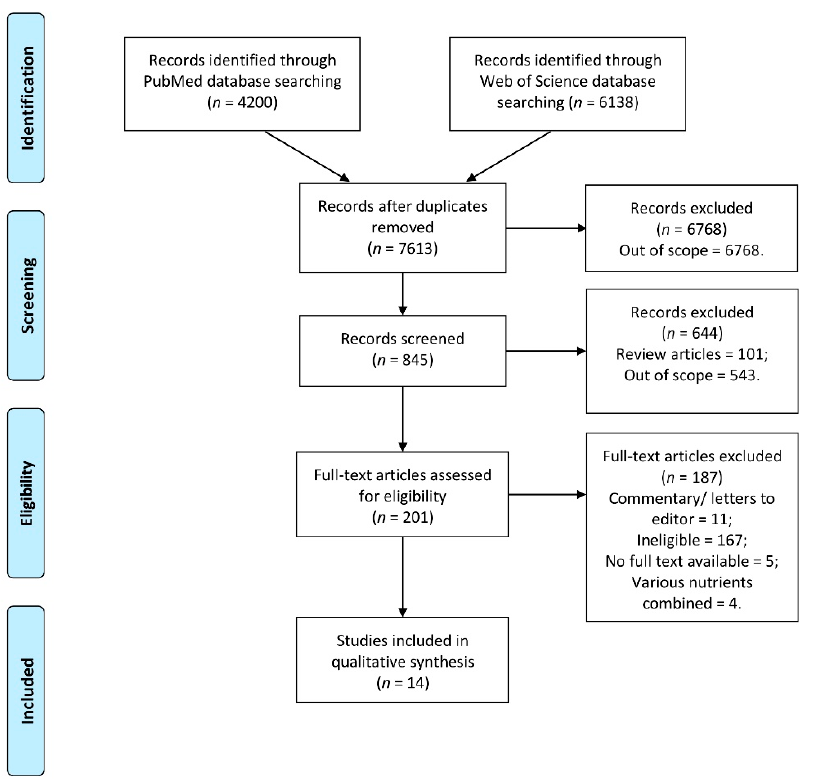
Figure 1. The inclusion procedure to the systematic review developed based on PRISMA 2009 flow diagram